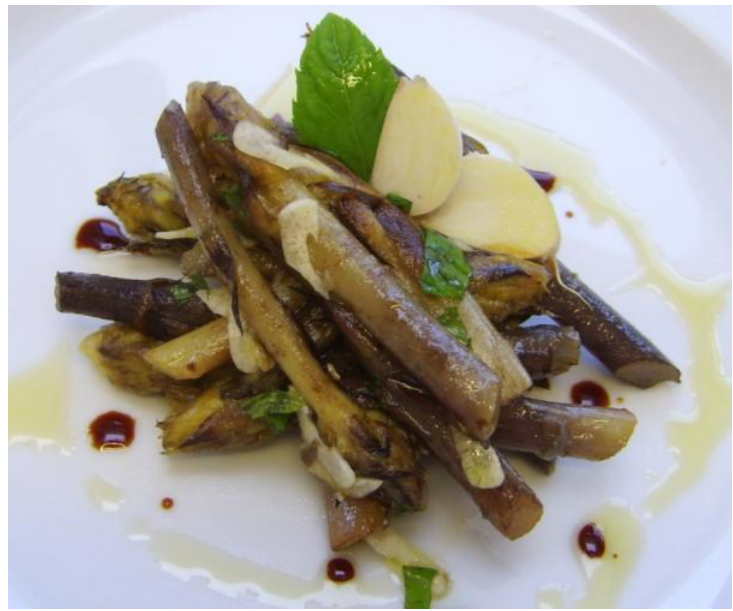
Figure 10. Salad of crenate broomrape.